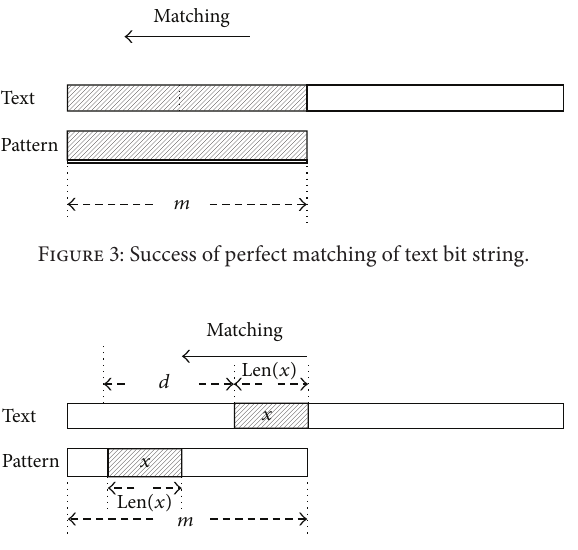
Figure 4: The good suffix matching of text bit string.